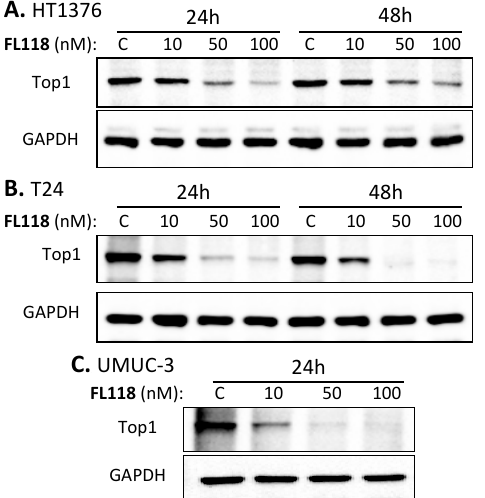
Figure 5. Sensitivity of bladder cancer cells to FL118 is irrelevant to Top1 level after FL118 treatment. Subconfluent bladder cancer cells in 6-well plates were treated with (10, 50, 100 nM) and without (C, vehicle control) FL118 for 24 h and/or 48 h, as shown, followed by Western blot analyses to determine the expression of Top1. ( A ) Treatment of HT1376 cells with FL118 resulted in the least inhibition of Top 1 expression after FL118 treatment. ( B ) Treatment of T24 cells with FL118 resulted in the inhibition of Top 1 expression after FL118 treatment. ( C ) Treatment of UMUC3 cells with FL118 resulted in the most inhibition of Top 1 expression after FL118 treatment. GAPDH presented in ( A – C ) is the internal control for total protein-loading.